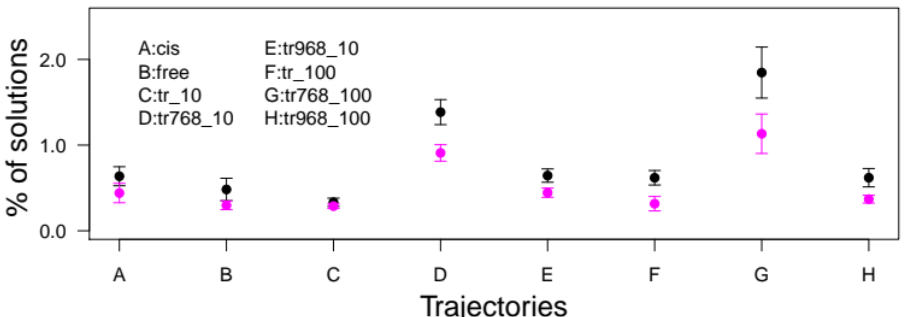
Figure 6. Numbers of FlexPepDock [20] solutions for the representative conformations extracted from different trajectories (see Supplementary Information). The number of solutions was normalized with respect to the number of docking trials and scaled by 10,000. These numbers of trials were 525,000 (cis), 595,000 (free), 665,000 (tr_10), 525,000 (tr768_10), 665,000 (tr968_10), 420,000 (tr_100), 280,000 (tr768_100), and 735,000 (tr968_100). The results are colored in black for the RhoA peptide and magenta for the Ras peptide. Table 2. Sequences of peptides docked on CNF1 conformations using FlexPepDock [20]. The Q63 residues undergoing deamidation are labeled with an asterisk (*).